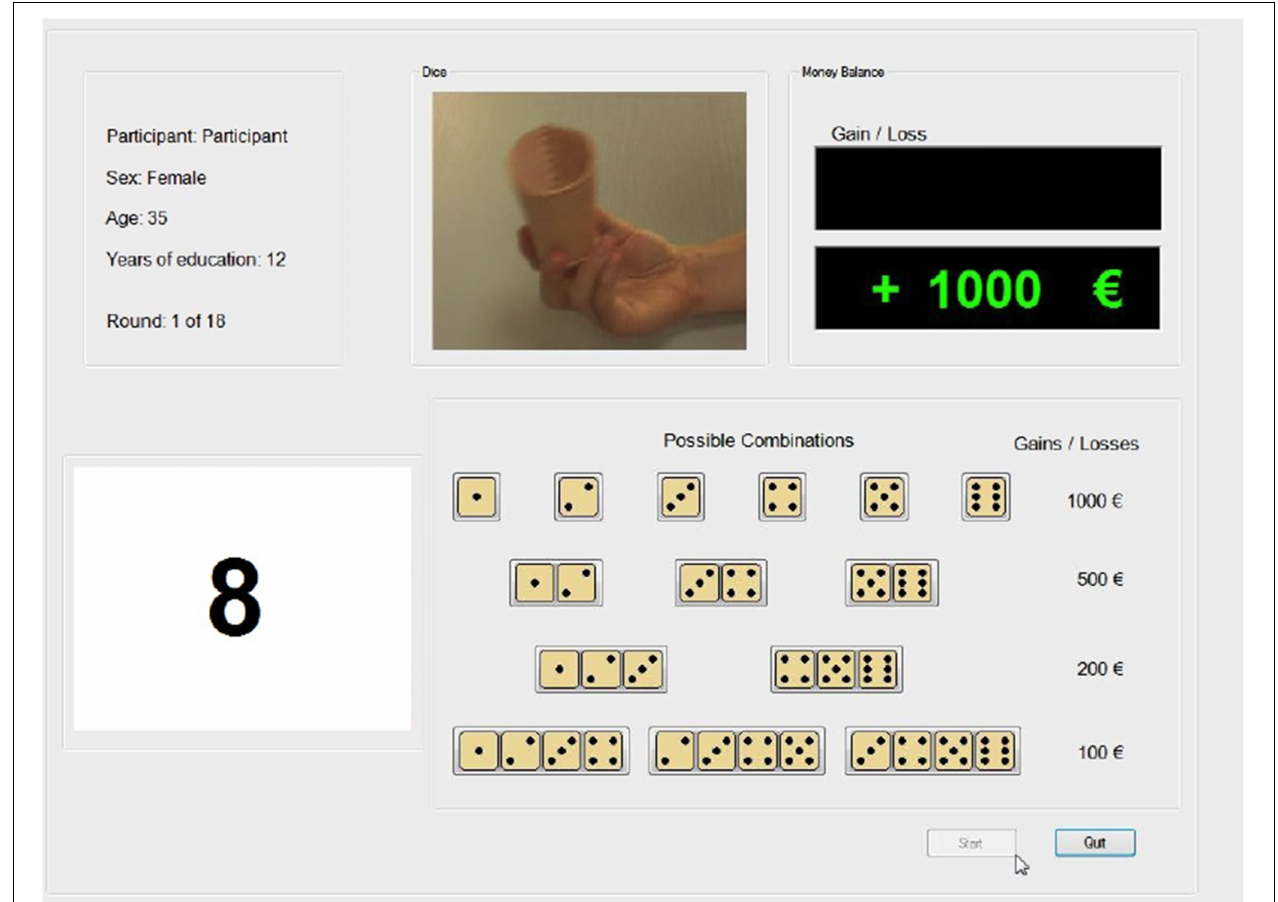
FIGURE 2 | Game of Dice Task plus 2-back task. On the right side of the screen, participants work on the Game of Dice Task (GDT) by betting which number will be thrown next. On the left side of the GDT interface,